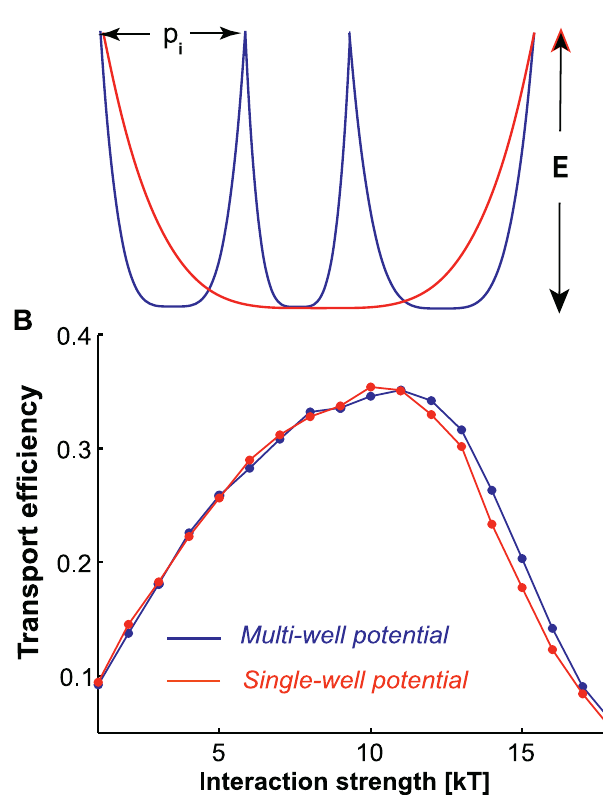
Figure 6. The Number of FG nups Does Not Significantly Affect the Transport Properties of NPCs (A) Effective potential for sparse flexible FG-repeat regions is shown as a blue line. Each well corresponds to an FG-repeat region. The transport properties in this multiwell potential are independent of the number of wells, and hence equivalent to those in the single-well potential, shown as a red line. (B) Numerical simulations show essentially identical transport efficiencies in the multiwell potential (blue line) and in the single-well potential (red